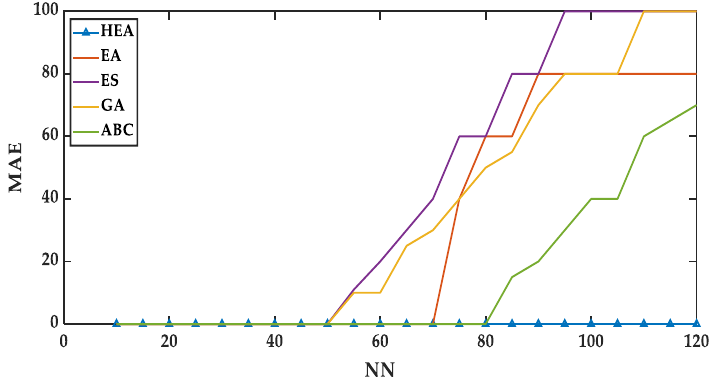
Figure 7. MAE -Testing values for different DHNN-RAN k SAT Figure 7. MAE-Testing values for different DHNN-RAN k SAT models. Table 7. Tabulated MAE-Testing values for different DHNN-RAN k SAT models.